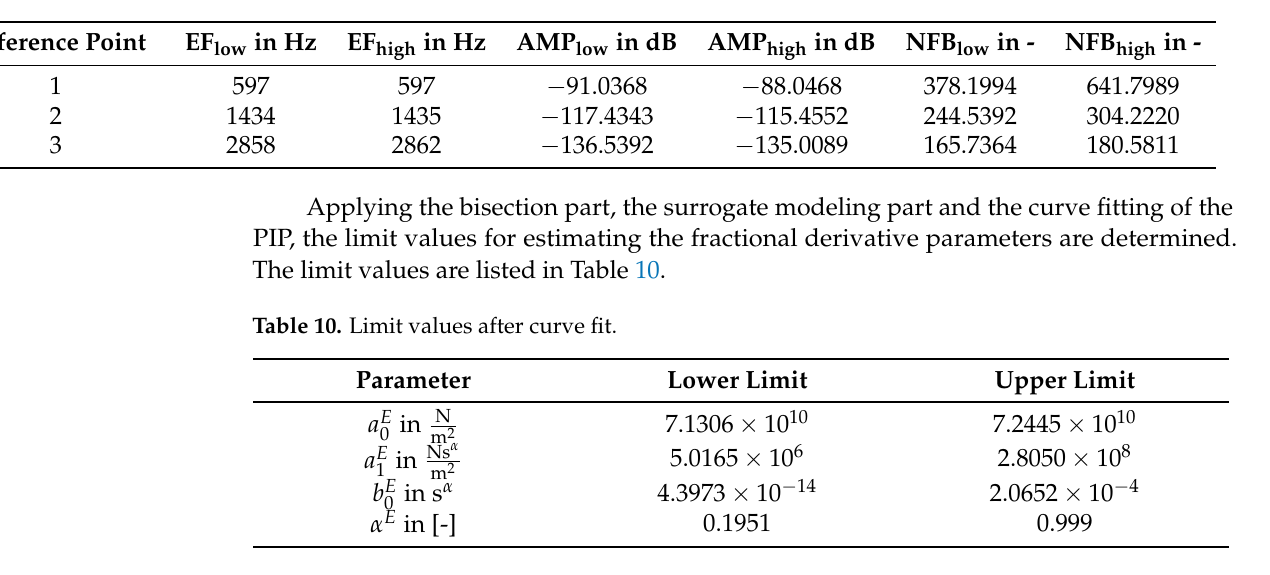
Table 9. List of the reference values of the measurement.